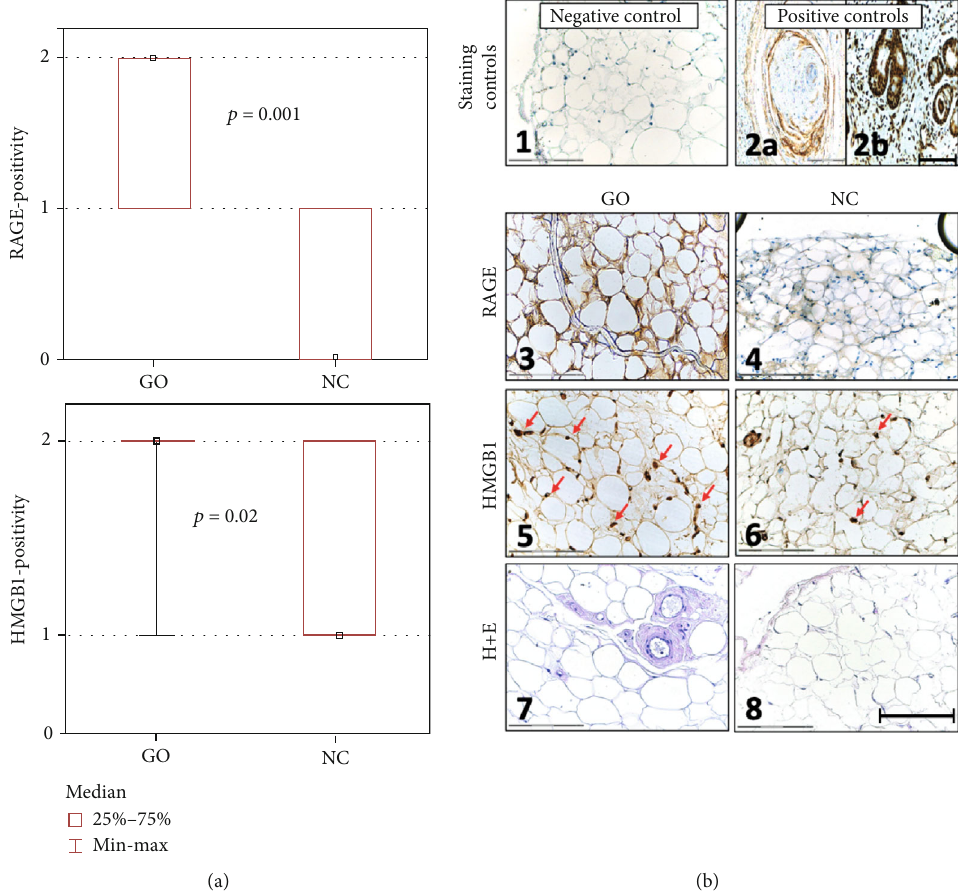
Figure 1: RAGE and HMGB1 expression in normal control (NC) and in Graves ’ ophthalmopathy (GO) tissues. ( a) Statistical analysis of RAGE and HMGB1 expression in GO tissues compared to NC. The sections were scored as described in Material and Methods. (b) Representative images of immunohistochemistry staining. B1: isotype negative control of GO tissue. B2: positive control. (a) RAGE expression on head and neck squamous cell carcinoma tissue. (b) HMGB1 expression on nasal cavity mucosa. B3: RAGE expression in GO tissue. B4: RAGE expression in NC tissue. B5: HMGB1 expression in GO tissue (arrows). B6: HMGB1 expression in NC tissue (arrows). B7: hematoxylin and eosin (H+E) staining of GO tissue. B8: H+E staining of NC tissue. p value ≤ 0.05 was considered to be signi fi cant. Bar=150 μ